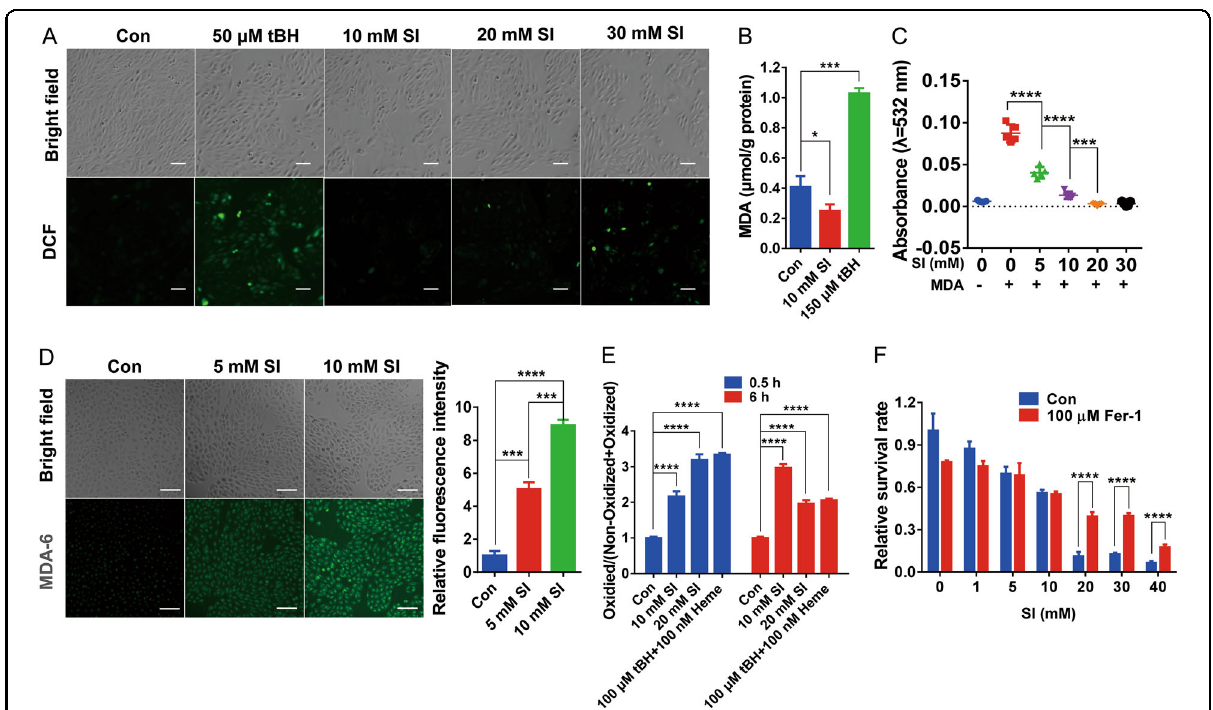
Fig. 4 SI promotes ROS generation and oxidative damage of lipids in ARPE-19 cells. A Concentration dependent induction of ROS by SI in ARPE-19 cells. Cells were stained with the green fl uorescent ROS probe DCFH-DA for 30 min and then exposed to 10, 20, or 30 mM NaIO 3 or 50 μ M tBH as a positive control for 30 min. Scale bar: 100 μ m. B Detection of MDA content by TBA test in cells treated for 24 h with 10 mM NaIO 3 or 150 μ M tBH. MDA level was expressed in μ mol/g protein ( n = 3). C In vitro reaction between SI and MDA. The residual MDA level was detected by the TBA test after 50 μ M MDA was incubated with indicated concentrations of NaIO 3 for 30 min at 37 °C ( n = 4). D Detection of MDA content by MDA-6. ARPE-19 cells seeded in a 96-well plate were treated with or without 5 mM or 10 mM NaIO 3 for 2 h followed by washing with PBS and staining with 10 μ M MDA-6. Left: Fluorescence images of cells stained with MDA-6. Scale bar: 100 μ m. Right: Quanti fi cation of fl uorescence intensity of fl uorescence images. E Peroxidation of lipids analyzed by BODIPY 581/591 C11. APRE-19 cells were preloaded with the probe BODIPY 581/591 C11 for 30 min followed by treatment with SI or tBH and heme at indicated concentrations for 0.5 or 6 h. Fluorescence of probe in oxidized (488/520nm) and non-oxidized (575/600nm) forms were monitored. The ratio of the oxidized BODIPY 581/591 C11 to the total BODIPY 581/591 C11 (oxidized plus non-oxidized) was calculated to represent the extent of lipid peroxidation ( n = 6). F The protective role of Fer-1 for SI-induced cell death. ARPE-19 cells pretreated with or without 100 μ M Fer-1 for 24 h were incubated with indicated concentrations of SI for an additional 24 h. The survival rate of cells was measured by the CCK-8 method ( n =